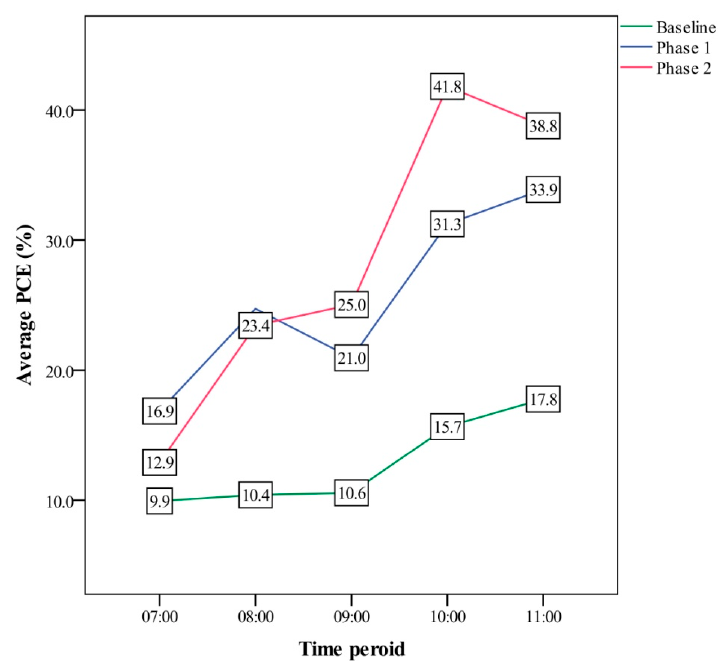
Figure 6. Comparison of PCE (%) at peak times among the three phases.